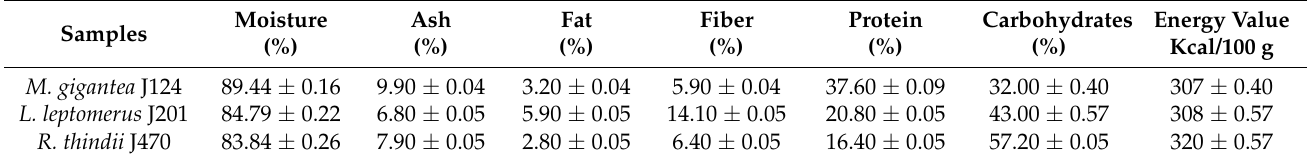
Table 1. Nutritional value of the three edible wild mushrooms in dry weight.